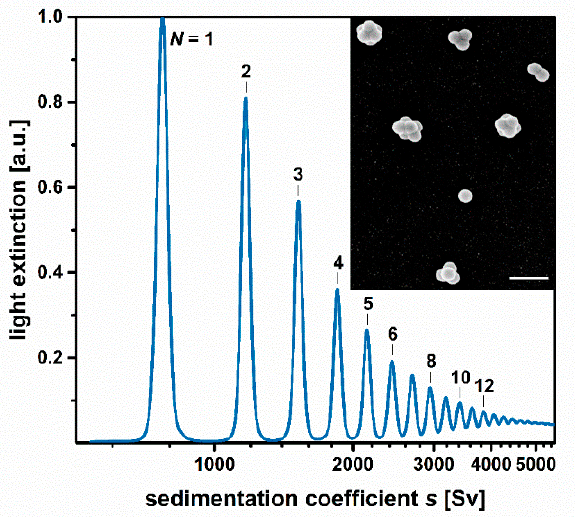
Figure 2. Sedimentation coefficient distribution of a mixture of colloidal clusters as measured by DCS. Cluster species of more than 12 constituent particles are resolved separately as narrow bands. DCS analysis thus enables a clear classification of nanoparticles according to their sedimentation characteristics. The inset shows an FESEM micrograph of the cluster mixture studied by DCS. The scale bar represents 400 nm.